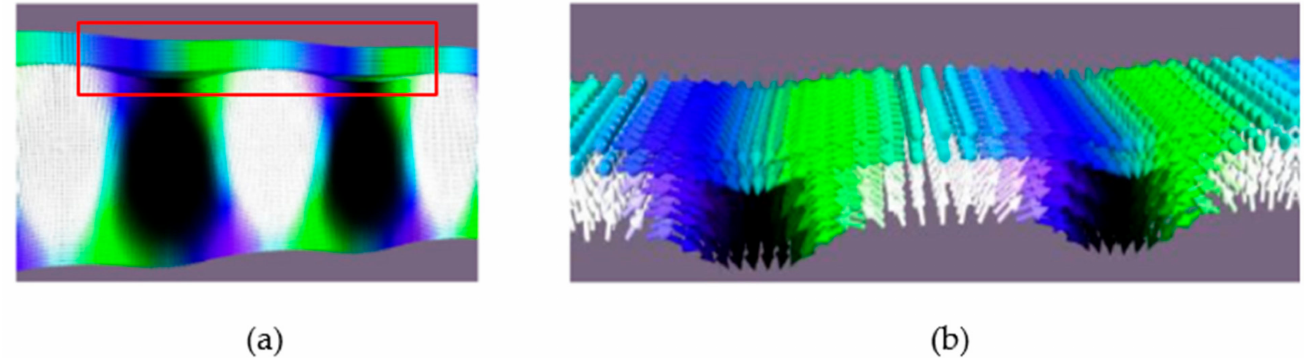
Figure 4. Remanent state of the NdCo 5 -(2.5 nm-Al)-Py; ( a ) global image of stripe domain structure; ( b ) zoom of the previous image (red triangle in ( a )) containing unitary vectors